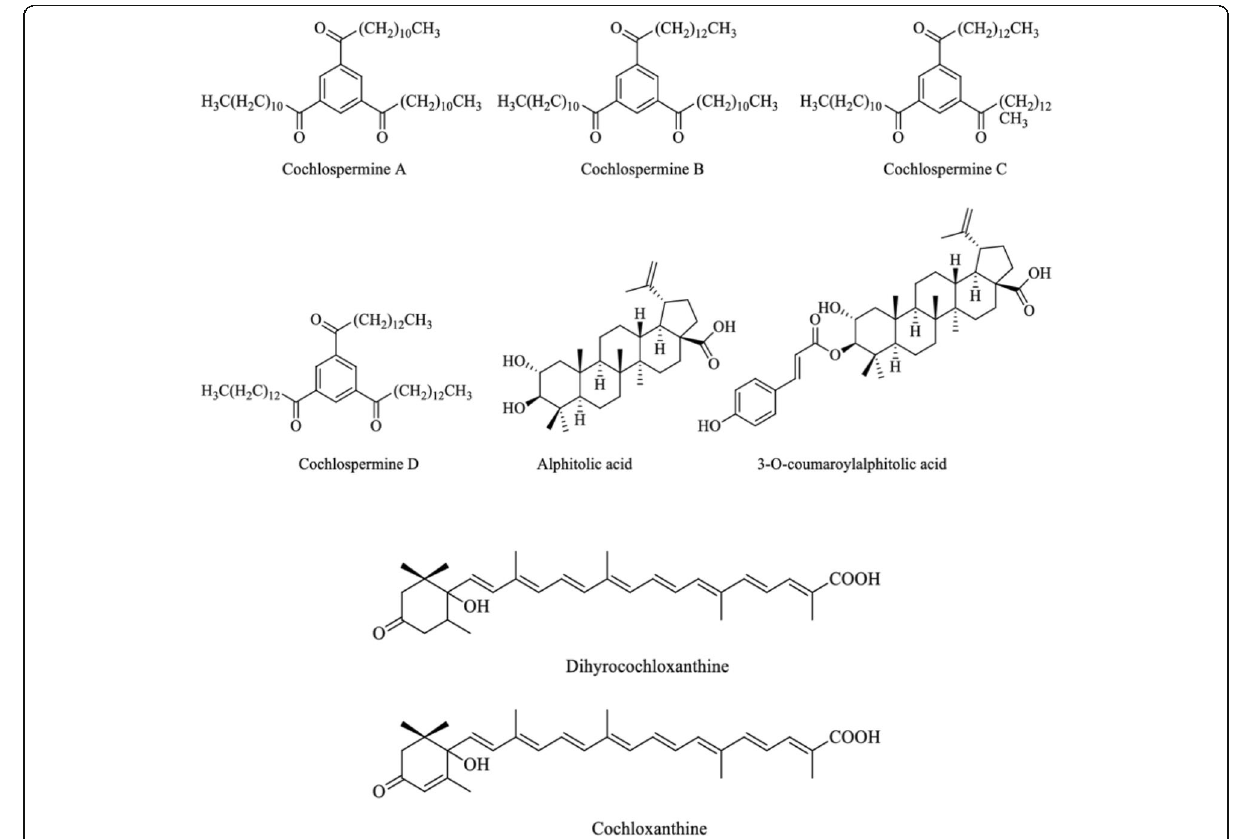
Fig. 2 Chemical structures of some bioactive compounds from Cochlospermum tinctorium